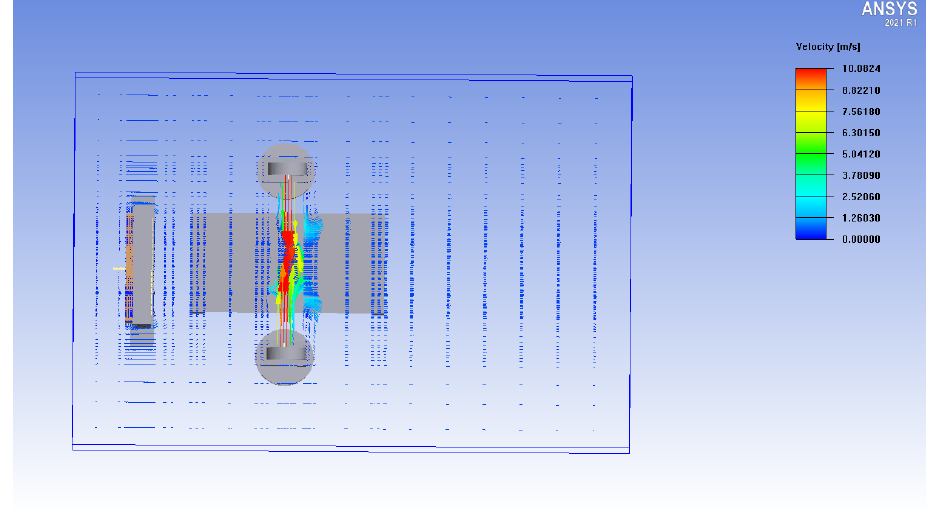
Figure 19. Air purifier simulation top view in the consulting room at a low rotation speed.